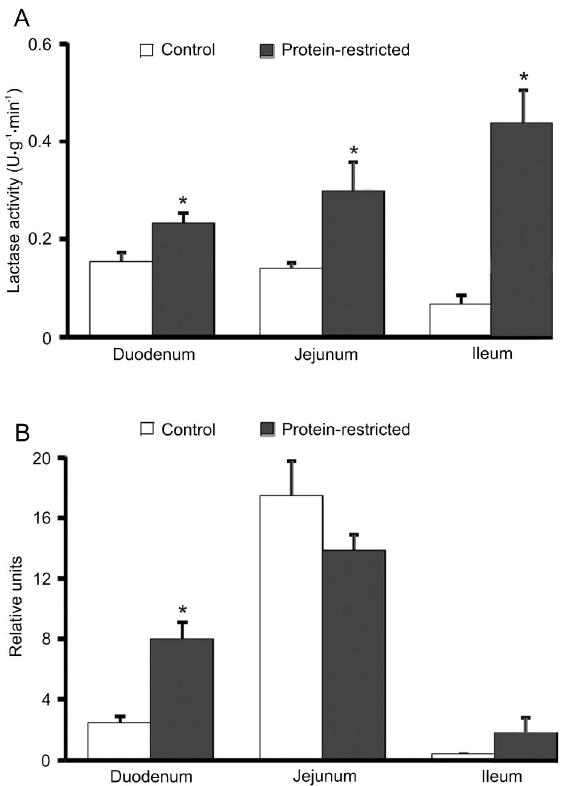
Figure 2. Sucrase activity ( A ) and sucrase mRNA abundance ( B ) in the intestine of 16-week-old rats (n = 5-8 animals) born to dams fed a protein-restricted (6% protein) or a control diet (17% protein). Data are reported as means ± SE. *P , 0.05 compared to control (Student t